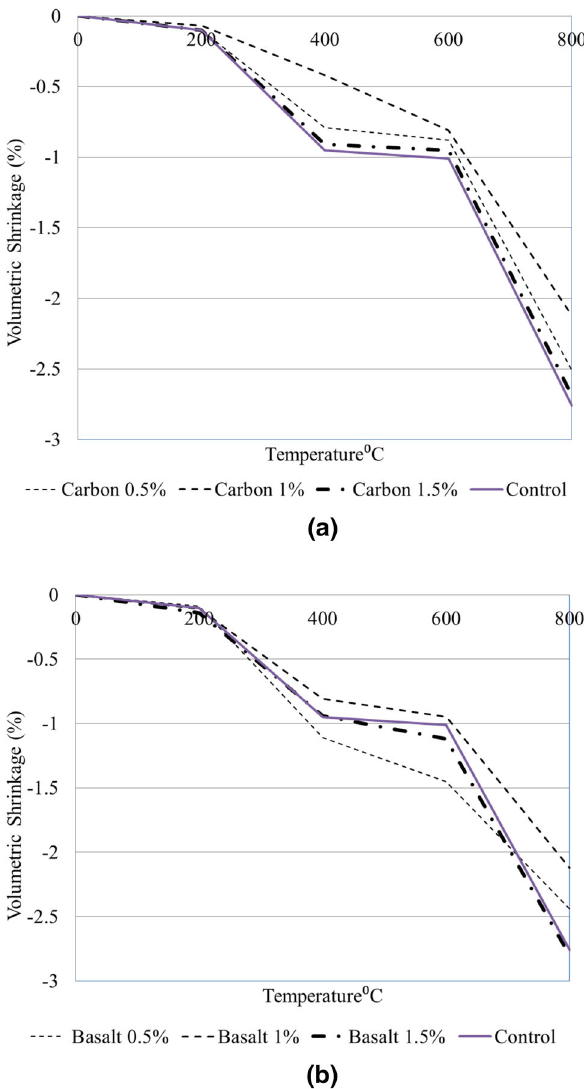
Fig. 3 Volumetric shrinkage of carbon and basalt fibre reinforced fly ash geopolymer composites at various elevated temperatures. a Carbon fibre reinforced fly ash geopolymer composite and b Basalt fibre rein- forced fly ash geopolymer composite.